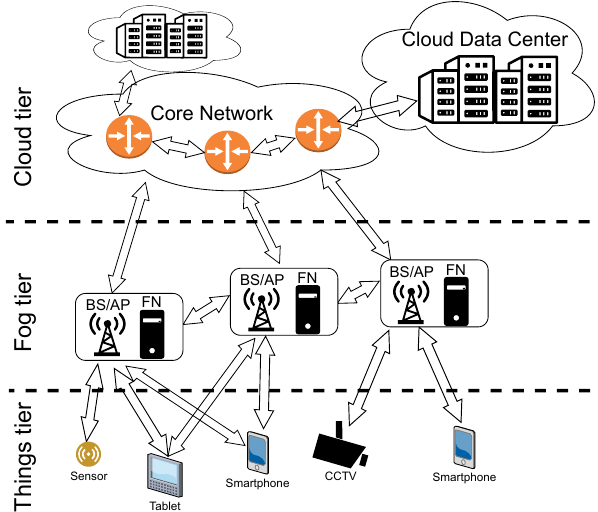
Figure 1. Example fog network